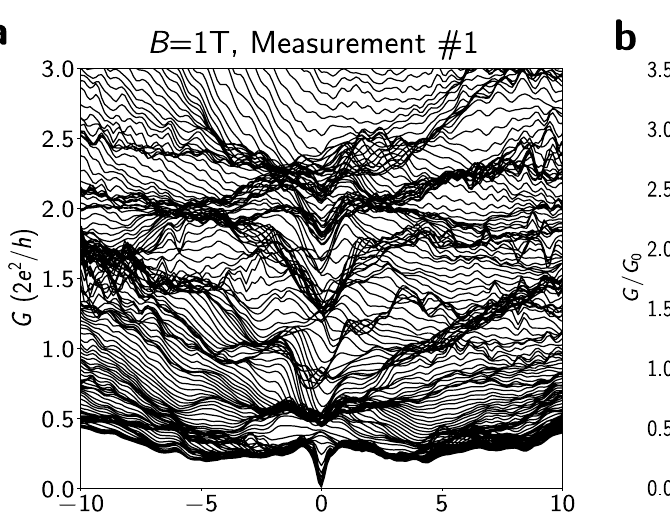
Fig.4|Single-modeMTJJ.a Differentialconductanceasafunctionofsource-drain bias V sd and gate voltage V g for terminal pair 1 and 2 for Device 1 at B =0 and T ~40mK. b Differentialconductanceasafunctionofgate voltagefordifferent V for Device 1 at B =0 and T ~40mK. The curves correspond to V sd values between